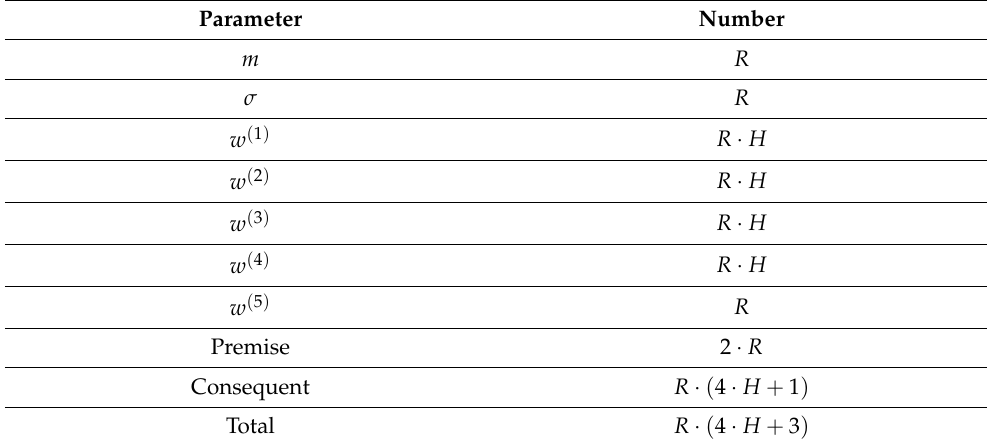
Table 1. Premise and consequent parameters (weights) of